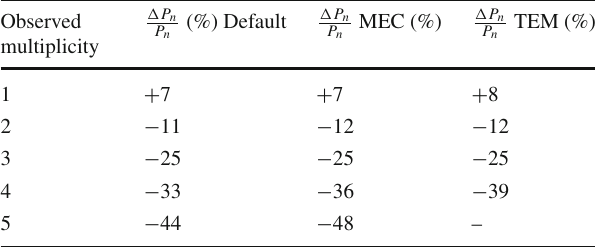
Table 7 Relative change in observed multiplicity probabilities corre- sponding to a − 15% uniform reduction in short charged particle track- ing efficiencies for three GENIE models: default, MEC, and TEM. The missing entry for observed multiplicity 5 in TEM is due to no event being generated with that observed multiplicity Observed multiplicity